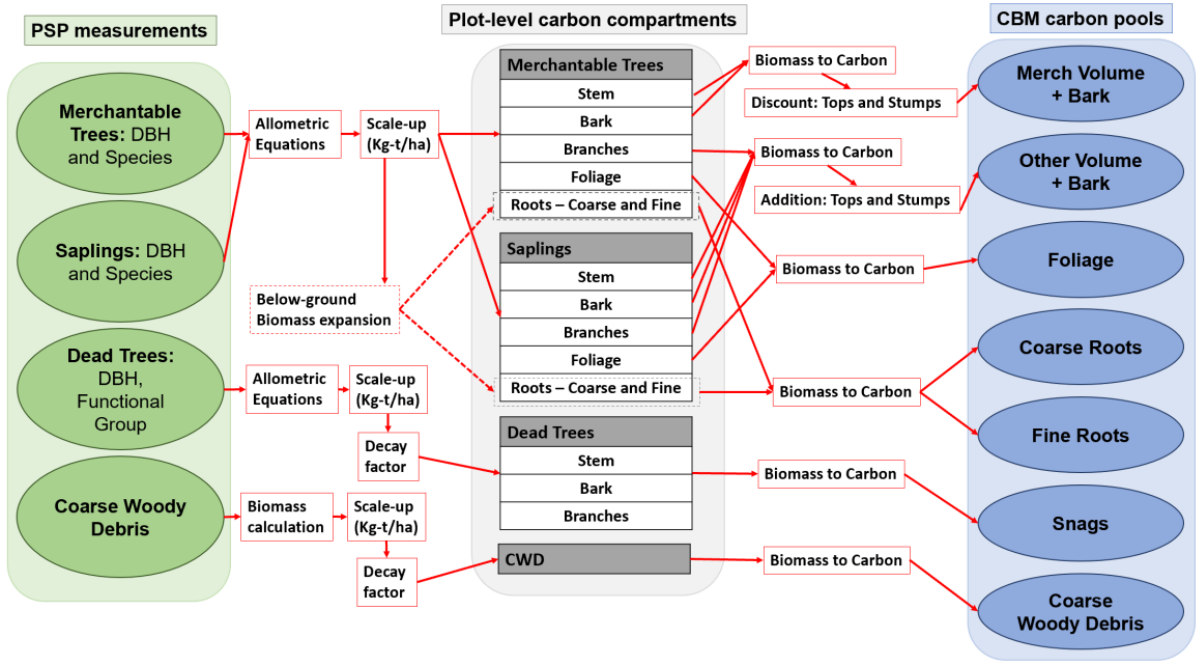
Figure 3. Flowchart of the methodology used to estimate plot-level IPCC and CBM-CFS3 carbon pools from PSP measure- ments.